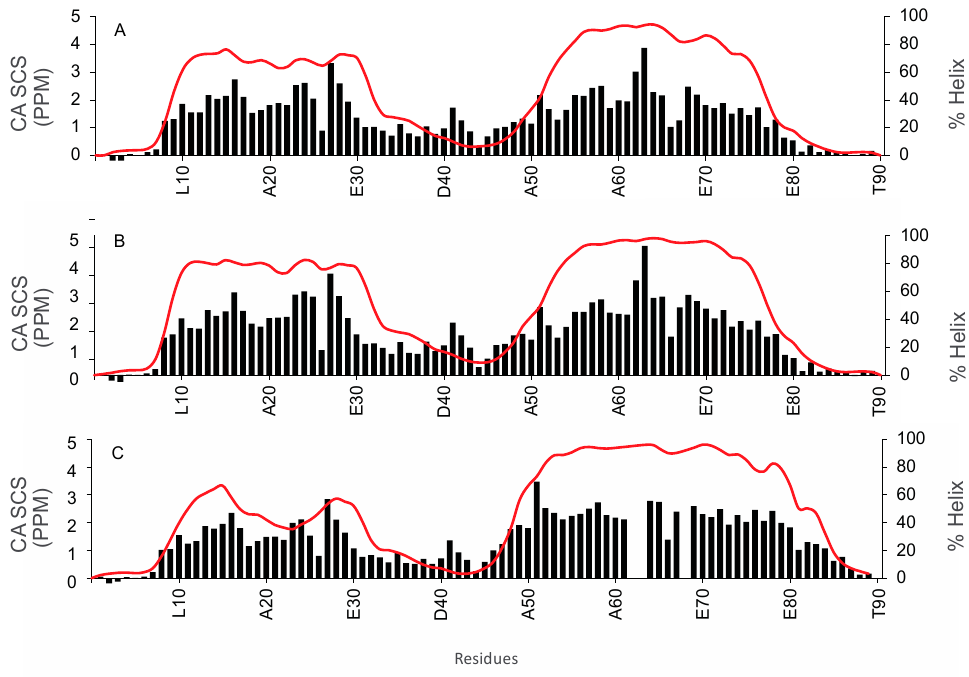
Figure 6. Residue-specific alpha carbon secondary chemical shift and % helix plot for COR15A WT and mutants in the presence of 20% TFE. Alpha carbon secondary chemical shifts (black bars) and % helix values (red line) measured using δ 2D data for COR15A WT and mutants in the presence of 20% TFE. The alpha carbon secondary chemical shifts are on the primary vertical axis and the measured % helix values are on the secondary vertical axis, while the residue number/position for every 10 residues is on the horizontal axis. ( A ): COR15A WT, ( B ): single glycine mutant G68A, ( C ): quadruple mutant 4GtoA, with glycine residues at positions 54, 68, 81 and 84 mutated to alanine